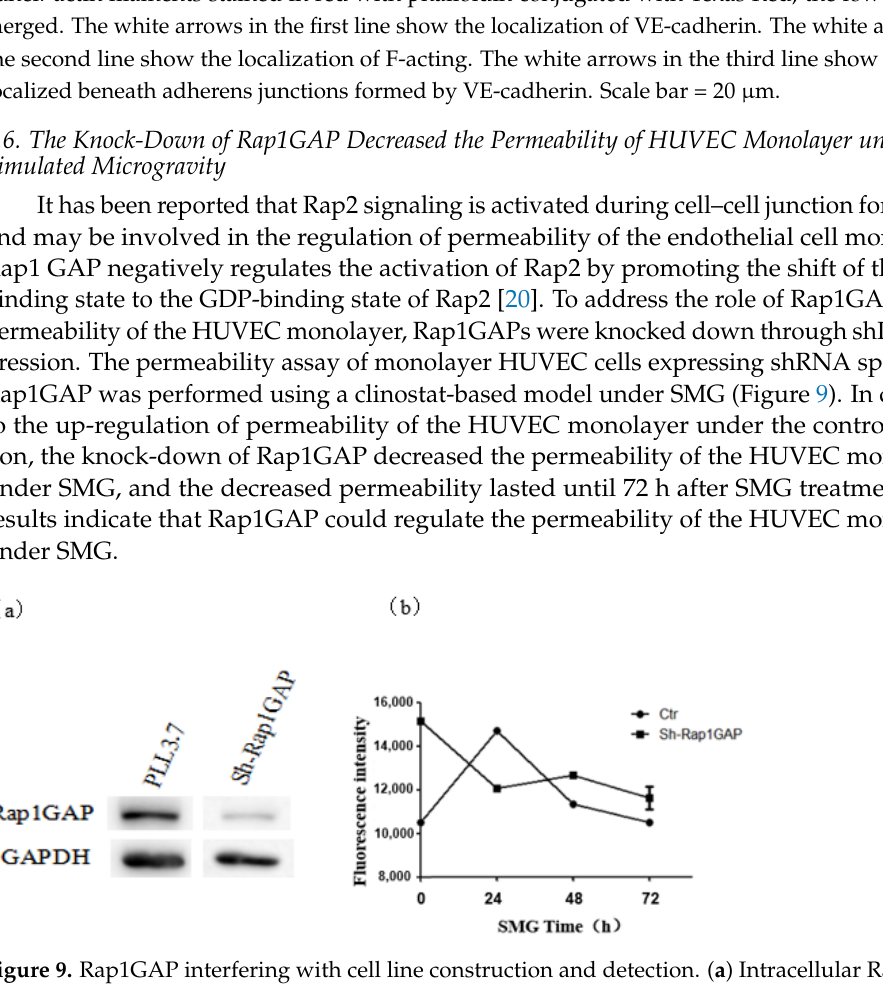
Figure 9. Rap1GAP interfering with cell line construction and detection. ( a ) Intracellular Rap1GAP interference efficiency. ( b ) The effect of simulated microgravity on the permeability of monolayer HUVEC cells after interfered with by Rap1GAP